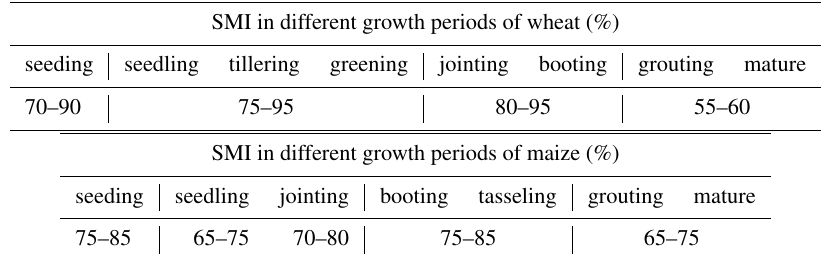
Table 2. Evaluation index of relative soil moisture (SMI) in different growth periods of crops at 0–10 and 10–20cm